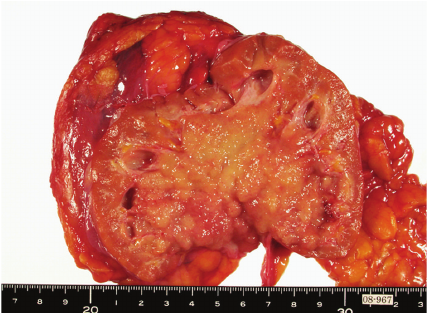
Figure 2: Crosssection photograph of the removed right kidney specimen, showing a tumor of 9 × 6 cm in size in renal